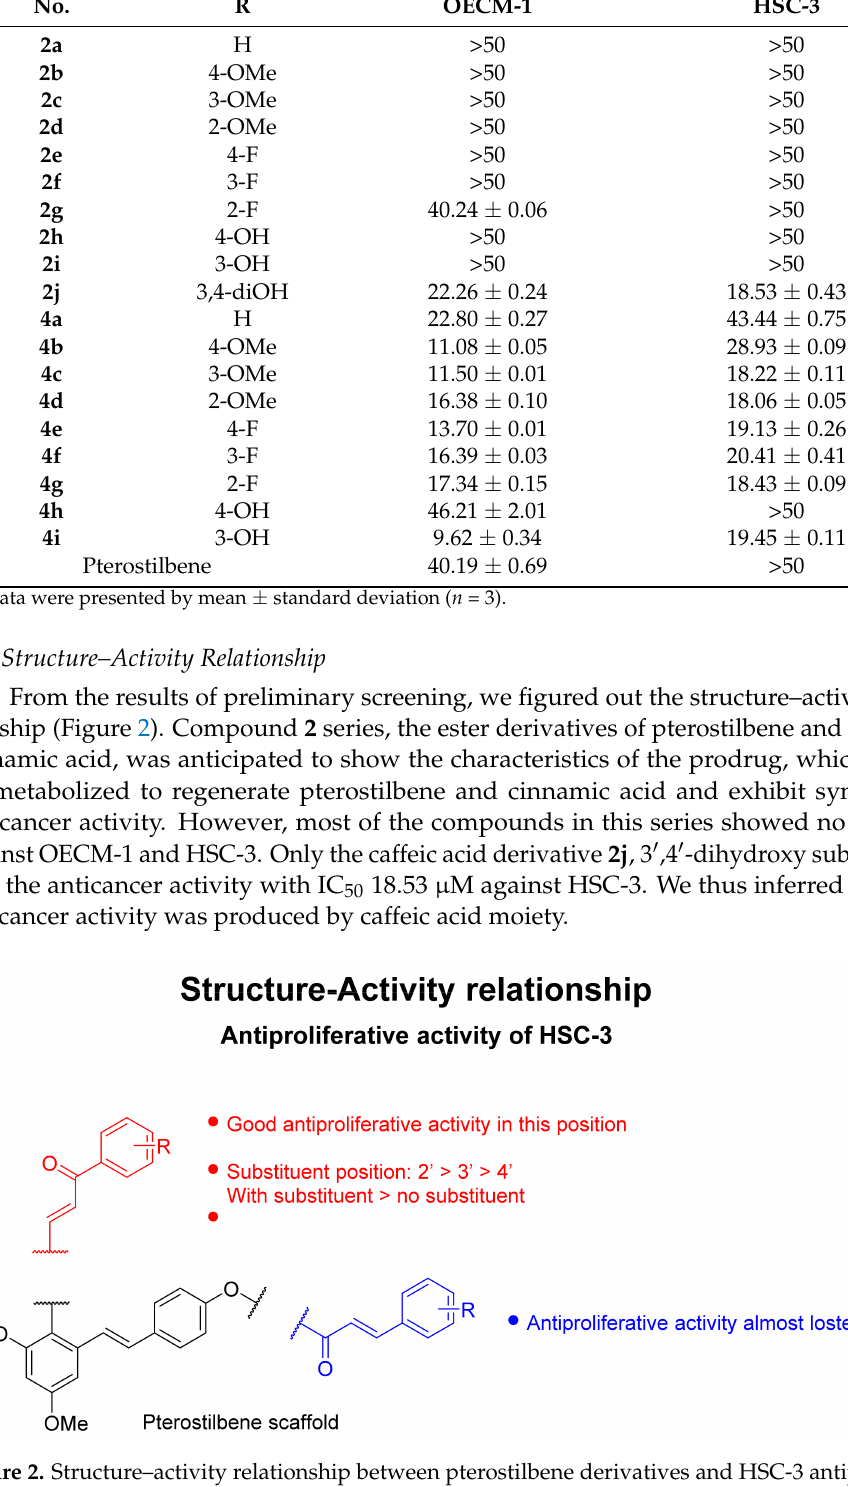
Figure 2. Structure–activity relationship between pterostilbene derivatives and HSC-3 antiprolifera- tive